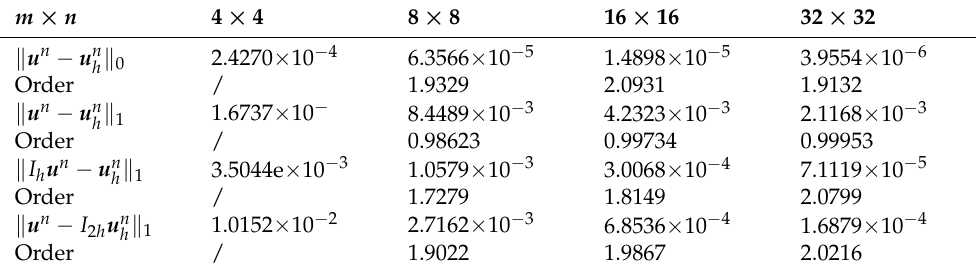
Table 3. The numerical errors and convergence orders at t = 0.6 of u .